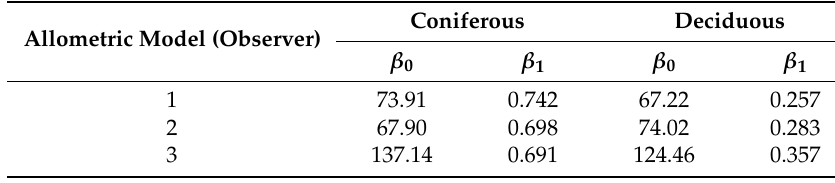
Table 2. Parameter estimates for the different allometric models.